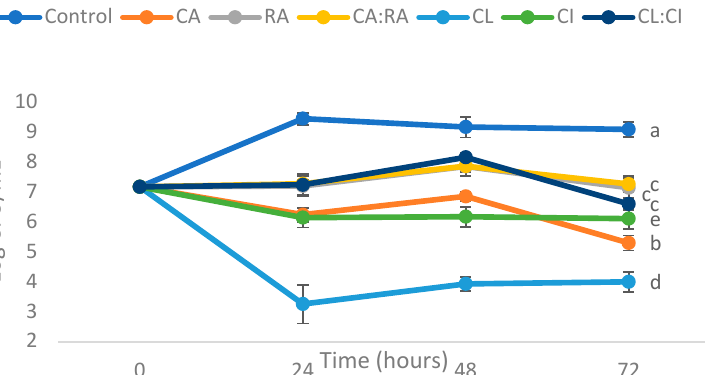
Figure 2. P. putida ESACB 191 growth curves by action of CA—Chlorogenic acid; RA—Rosmarinic acid; CA:RA—50% Chlorogenic acid + 50% Rosmarinic acid, and C. cardunculus extracts: CL— Leaves decoction; CI—Inflorescence decoction; CL:CI—50% leaves decoction + 50% inflorescence decoction. The concentration 1 mg/mL was used for all samples tested in Müller–Hinton Broth with 1% L-tyrosine.